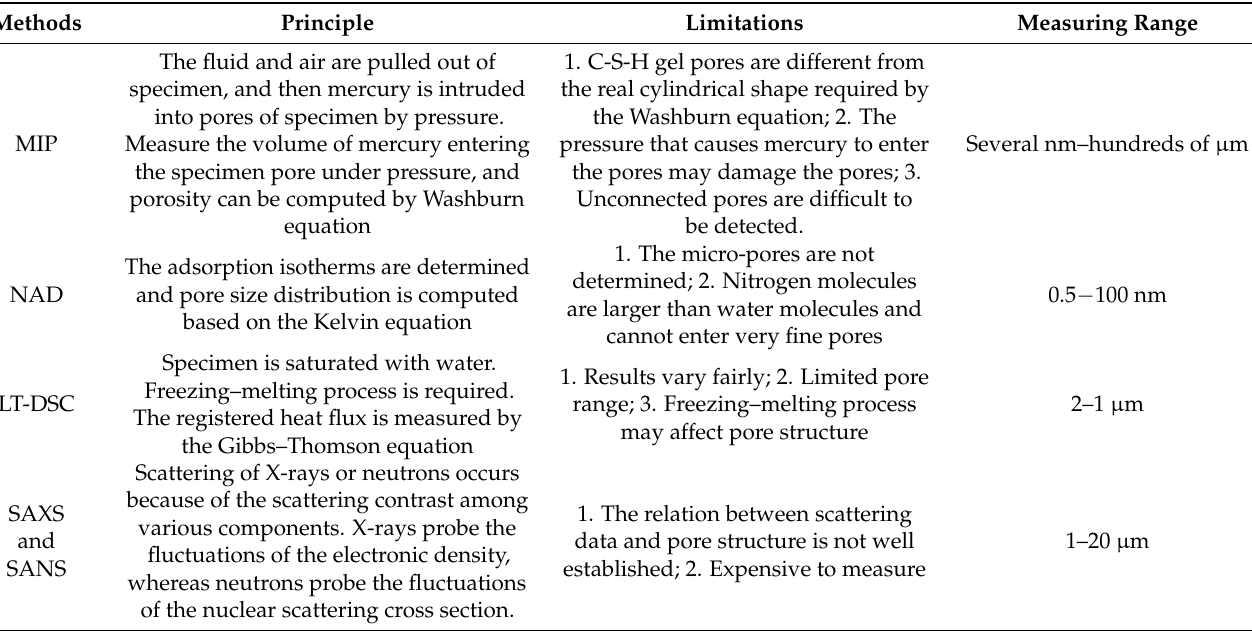
Table 3. Summary of experimental methods for pore structure of cement-based materials [126].